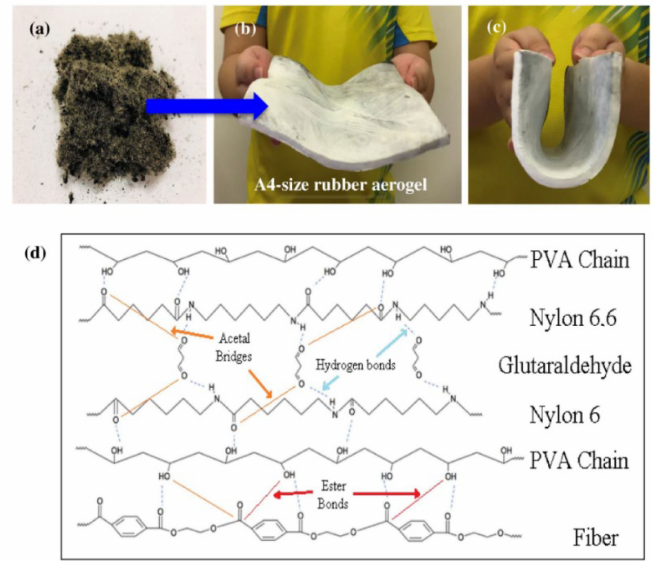
Figure 14. ( a ) Raw WTTF obtained from shredding the car tire waste, ( b ) A4-size rubber aerogel, ( c ) high flexibility of the rubber aerogel and ( d ) proposed formation mechanism between the WTTF and the crosslinkers inside the rubber aerogel